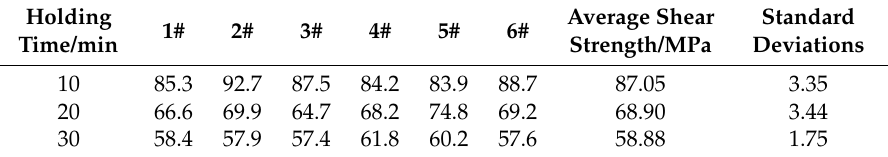
Table 2. The shear strength for the samples brazed for different holding times at 535 °C. Holding